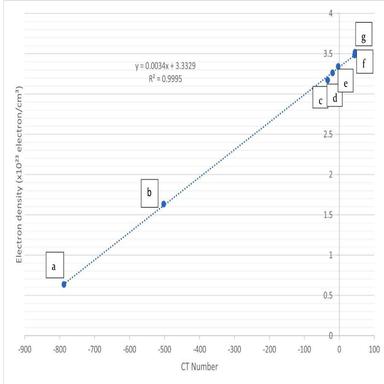
Electron density calibration curve against CT number at tube current of 120 kVp a Lung (inhale), b Lung (exhale), c Adipose tissue, d Breast (50/50), e Water, f Muscle, g Liver.